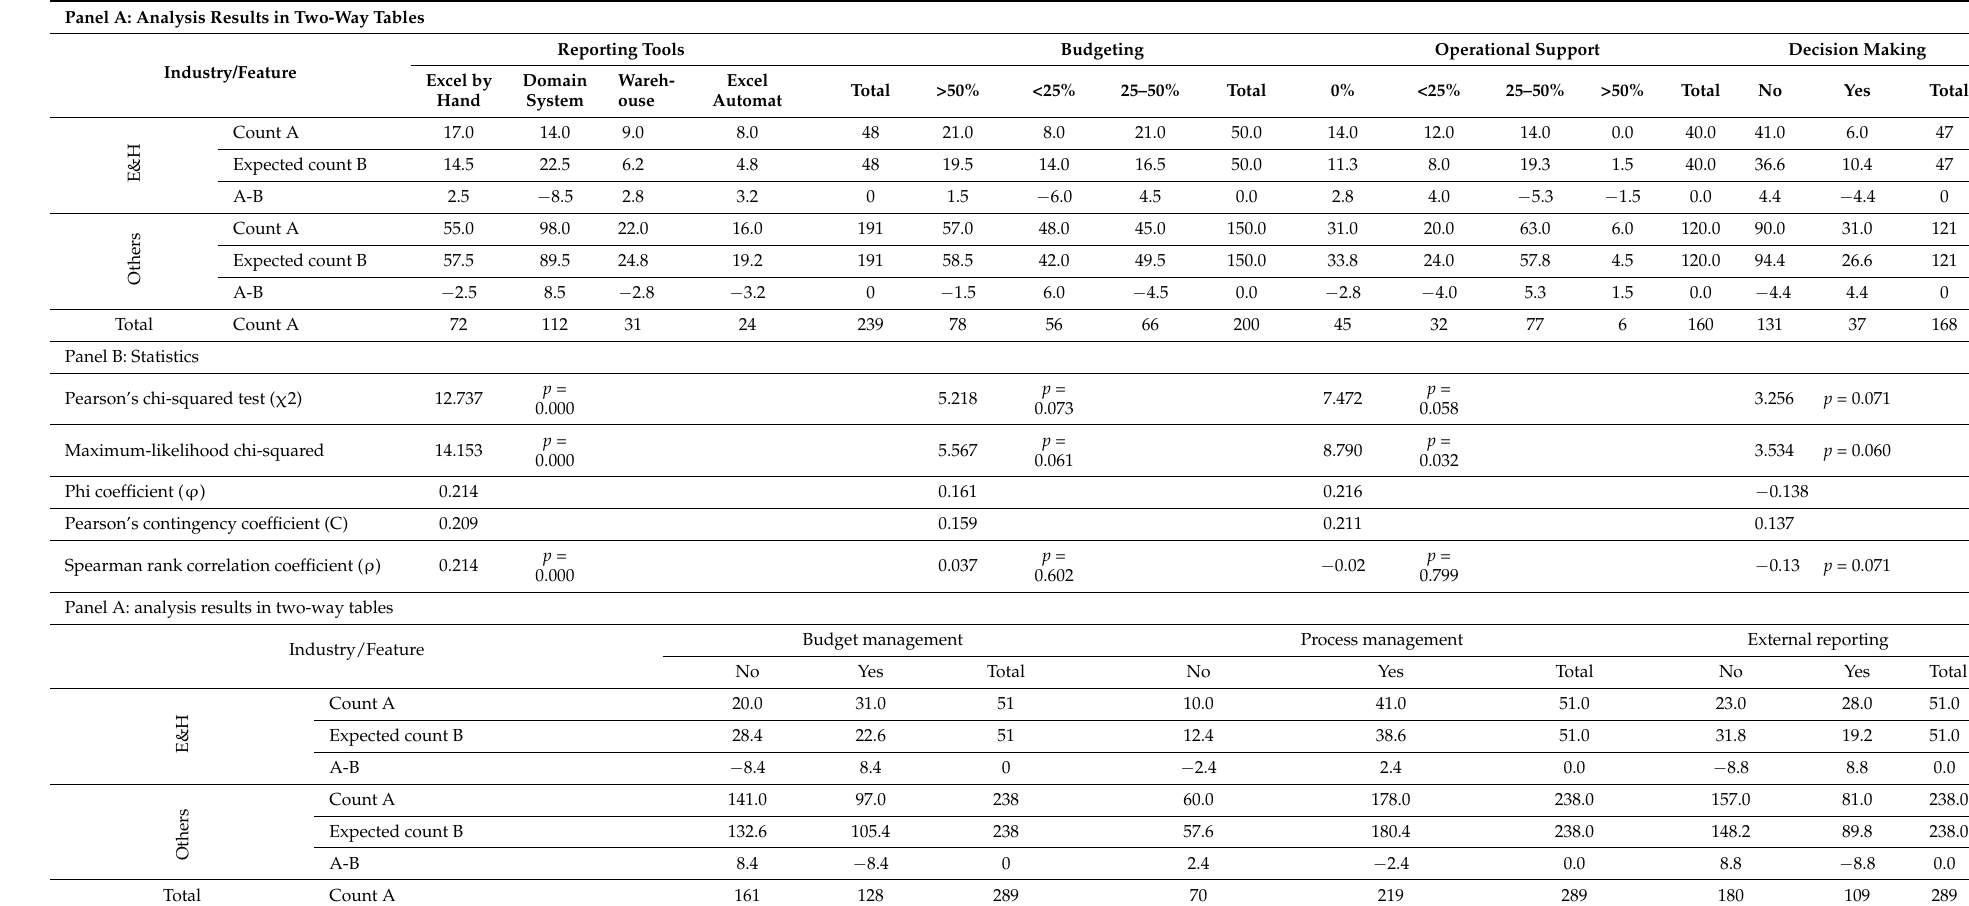
Table 9. The tasks and role of controlling indicated by the